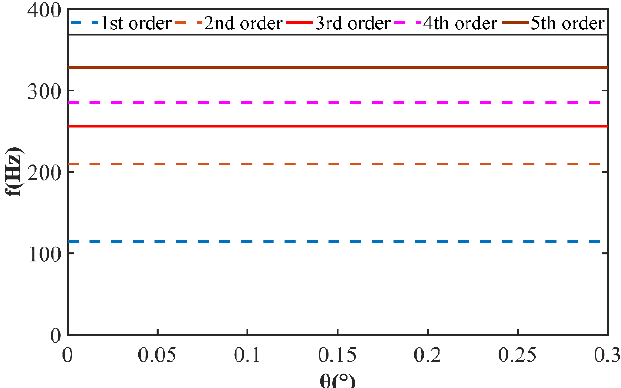
Figure 19. Variation trend of natural frequency of rear deflection angle non-concentricity in the range of 0° ~ 0.3°.